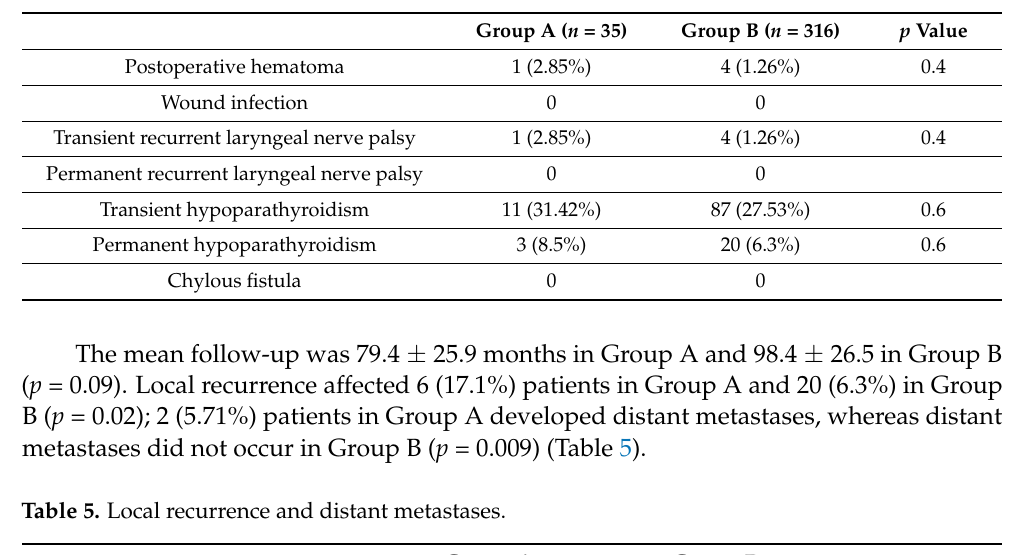
Table 4. Postoperative complications.